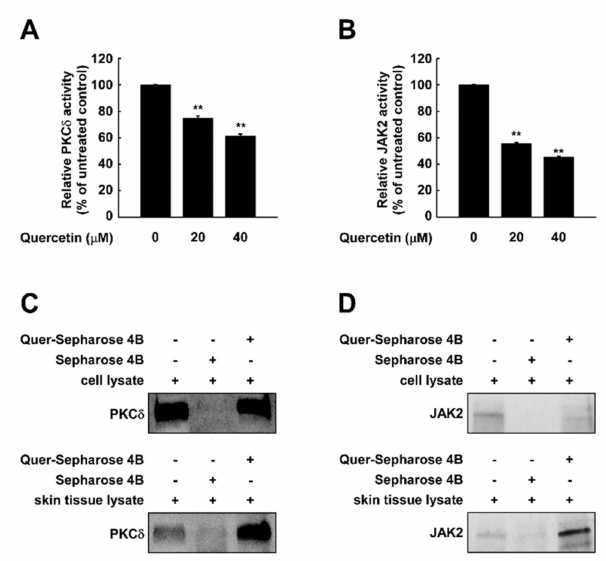
Figure 5. Quercetin binds to and inhibits PKC δ and JAK2 kinase. Kinase assays was performed with ( A ) PKC δ or ( B ) JAK2 protein. Pull-down assays were performed to detect the binding of quercetin with PKC δ or JAK2. Binding between PKC δ -and quercetin or between JAK2- and quercetin were confirmed in JB6 P + cells and human skin tissues by immunoblotting using antibodies against ( C ) PKC δ or ( D ) JAK2. Lane 1: whole lysates isolated from cell or tissue; lane 2: lysates of cell or tissue samples were precipitated with Sepharose 4B-alone; lane 3: whole cell lysates from cell or tissue were precipitated with quercetin-Sepharose 4B beads (Quer-Sepharose 4B). ** indicate significant ( p < 0.001) inhibition of activity by quercetin compared to un-treated control.